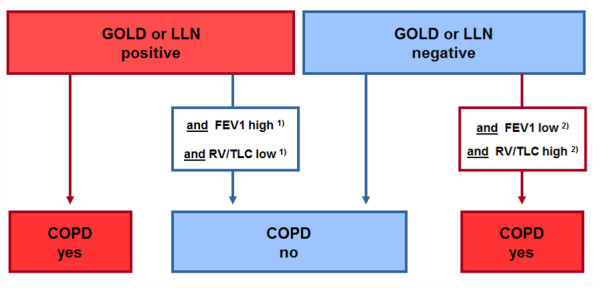
Flow chart for diagnostic algorithm. In clinical practice the diagnosis of COPD is based on multiple variables. As the simplest model we chose a three PFT parameters approach in which an initial COPD YES/NO diagnosis based on FEV/FVC levels was corrected if FEV1 and RV/TLC levels were altered counterintuitively*. * As thresholds for FEV1 and RV/TLC levels different cut-off levels were used and kappa statistics calculated for all alternatives. Each change in COPD diagnosis only materializes if both parameters deviate by ≤ 5/7.5/10/12.5/15/20% from 100% of the predicted value. Example: If deviations of 10% (from 100%) are chosen as thresholds for both FEV1 and RV/TLC (as % of predicted) in order to change the GOLD-COPD diagnosis from 1) 'yes' into 'no' (i.e., FEV1 ≥ 90% and RV/TLC ≤ 110%; [2) or vice versa, from 'no' into 'yes', FEV1 < 90% and RV/TLC > 110%]), then the number of misclassified patients (false positives + false negatives) is reduced from 69 to 33, and κ- statistics improve from 0.64 to 0.83. Abbreviations: as in table 1.